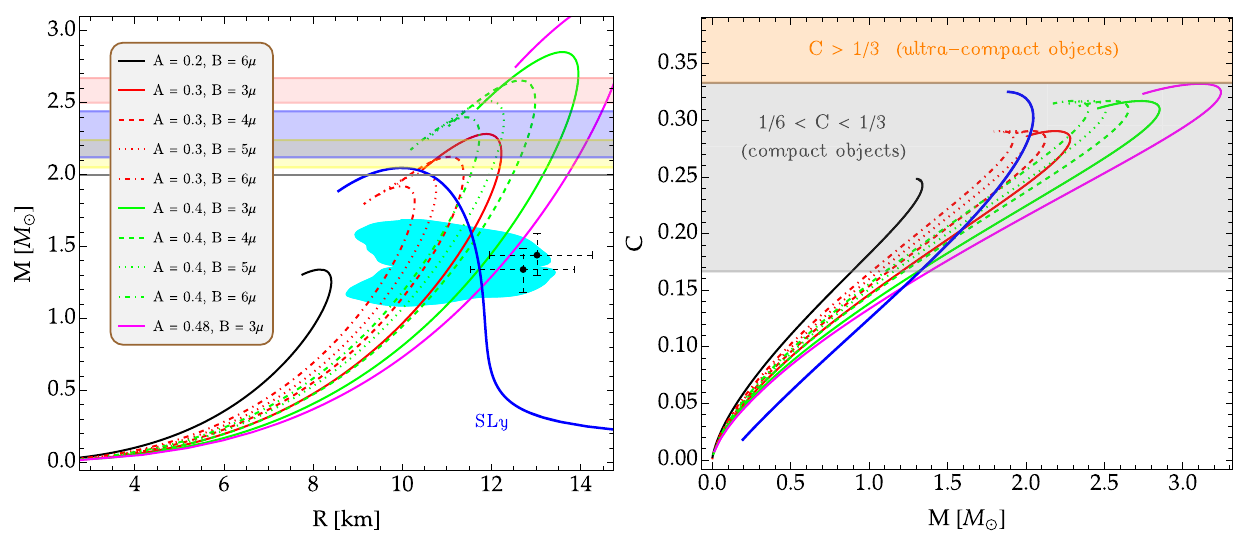
and the cyan area is the mass-radius constraint from the GW170817 event. Moreover, the NICER measurements for PSR J0030+0451 are displayed by black dots with their respective error bars [95,96]. Right panel: Variation of the compactness with total gravitational mass, where the gray and orange stripes represent compact and ultra-compact objects, respectively, according to the classification given in Ref. [92]. For comparison reasons, we have included the results corresponding to the SLy EoS [93] by blue curves in both